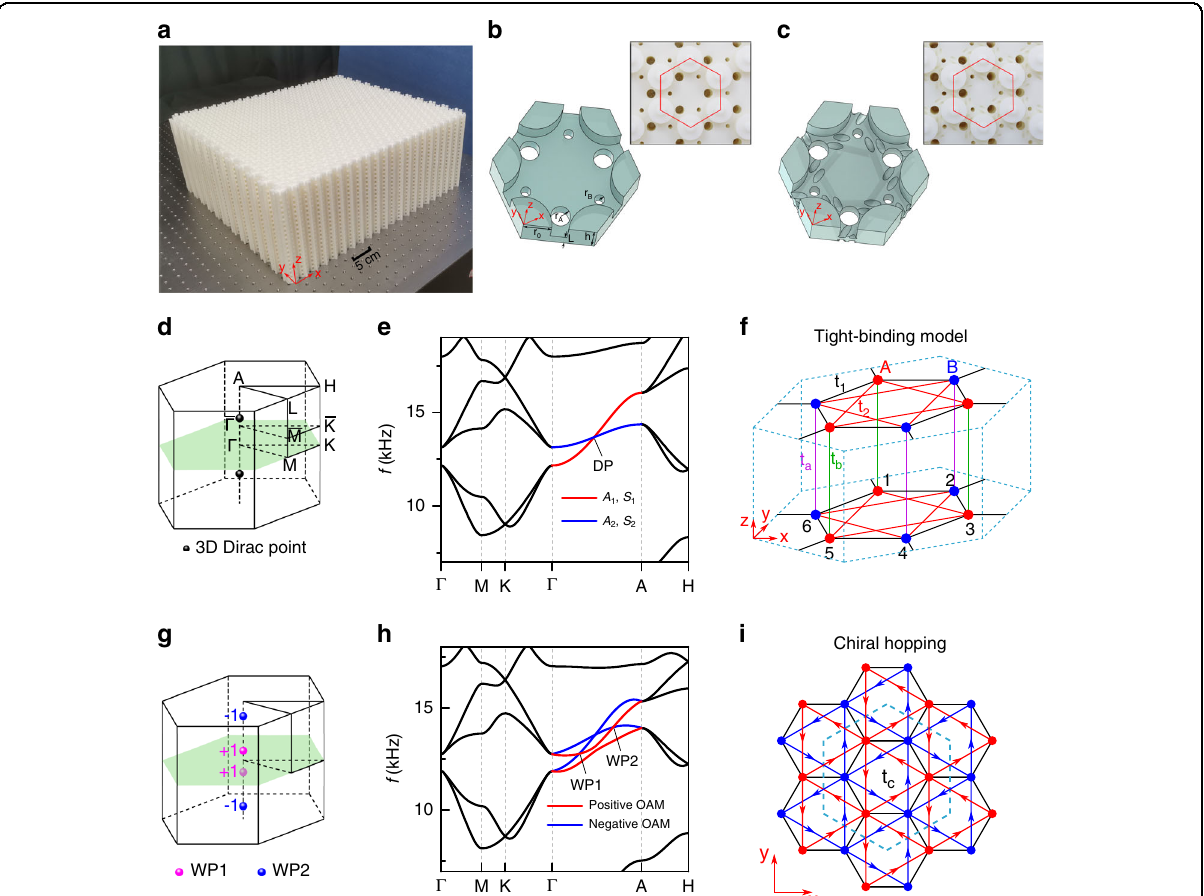
Fig. 1 A 3D Dirac sonic crystal and its transition to a Weyl sonic crystal. a Photograph of the 3D Dirac sonic crystal. b , c Geometry of the unit cells for b the 3D Dirac sonic crystal and c the Weyl sonic crystal with additional chiral hopping tubes. The insets of b and c show top- view images of the 3D Dirac and Weyl sonic crystals. One unit cell is outlined with a red hexagon for each sonic crystal. d The Brillouin zone (BZ) of the 3D Dirac sonic crystal. e The band structure of the 3D Dirac sonic crystal where a Dirac point (DP) is located on Γ A . f Tight-binding model of the 3D Dirac sonic crystal, including nearest-neighbour hopping and next-nearest-neighbour hopping. g The BZ of the Weyl sonic crystal, where each 3D Dirac point splits into a pair of Weyl points, WP1 and WP2, with charges of + 1 and − 1, respectively. h The band structure of the Weyl sonic crystal. States with positive orbital angular momentum (OAM) and negative OAM are represented by red and blue lines, respectively. i Additional chiral interlayer coupling in the Weyl sonic crystal. The arrows represent the direction of positive phase